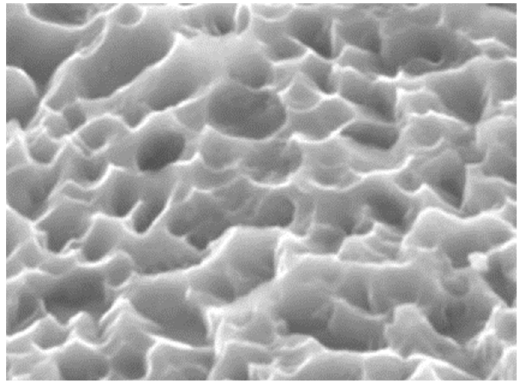
Figure 5. Typical dental implant surface morphology using acid-etching. (Reproduced with permission from [161]. Copyright Elsevier, 2013).